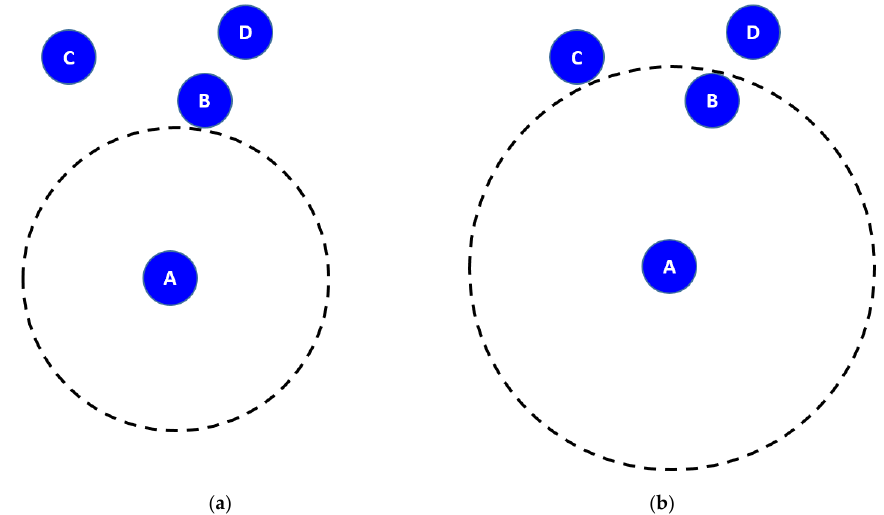
Figure 13. Adaptive neighbor determination. ( a ) No neighbor in the range of node A, ( b ) Node A increases power to be able to access neighbors.